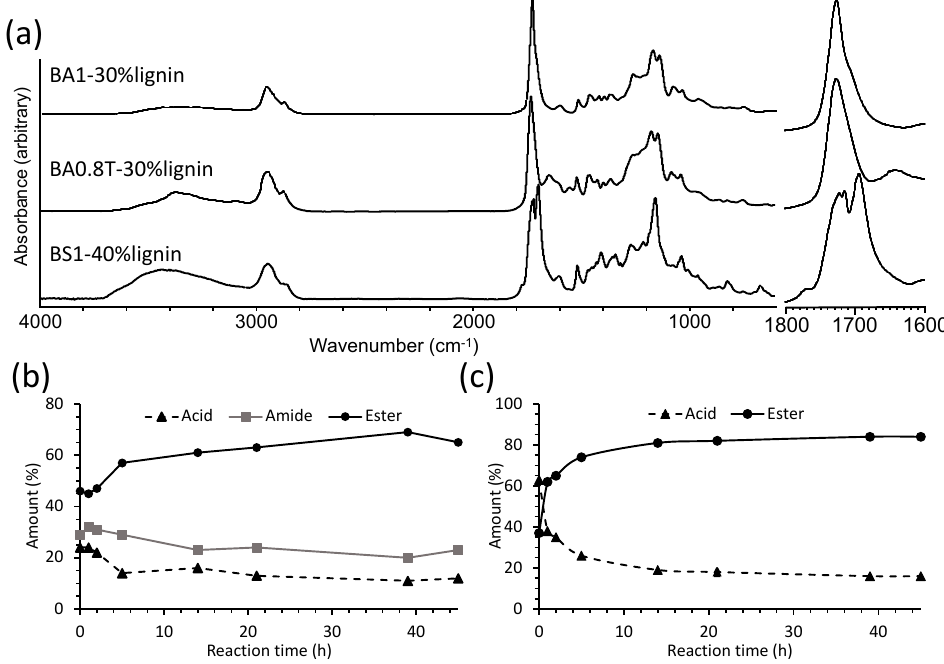
Figure 4. ( a ) FTIR spectra plus expanded carbonyl region of BA0.8T-30%lignin, BA1-30%lignin and BS1-40%lignin copolymers after reaction for 45 h and plots of acid, ester and amide carbonyl content determined by FTIR spectroscopy with reaction time for the lignin-copolymer ( b ) BA0.8T-30%lignin and ( c ) BA1-30%lignin.